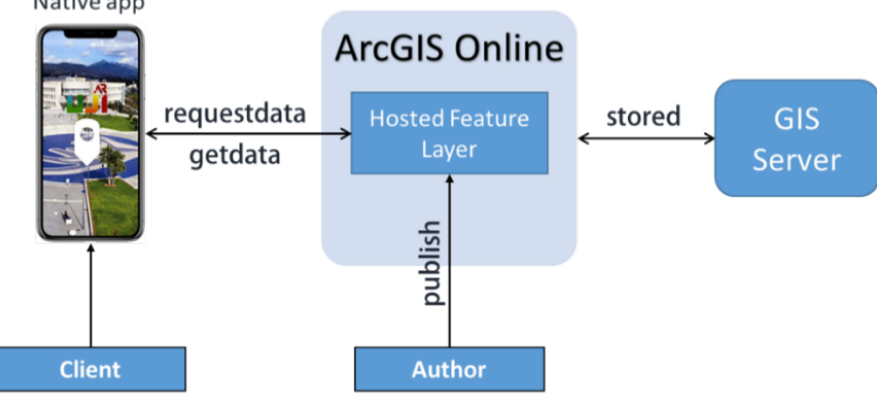
Figure 4. Architecture of the AR App.